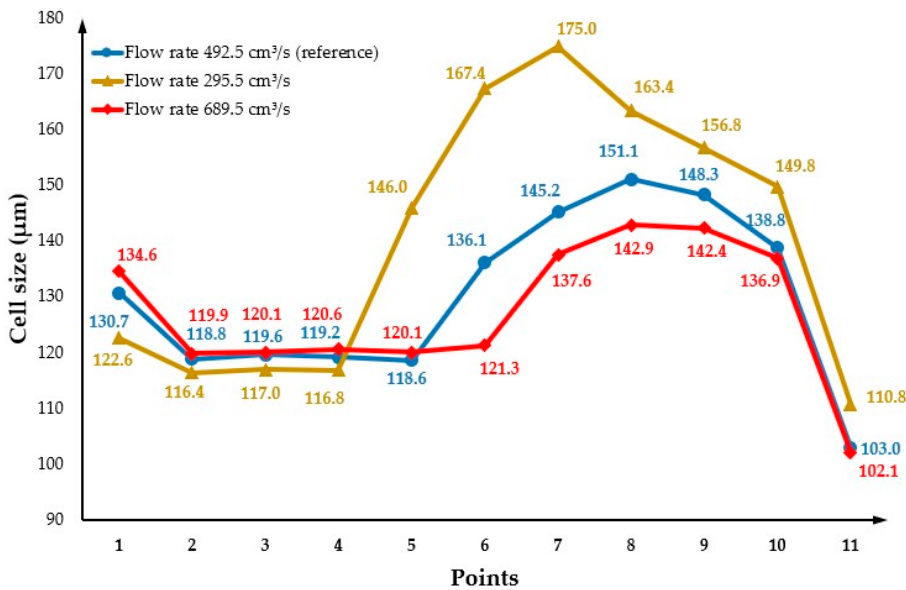
Figure 20. Cross-section variation in cell size as a function of flow rate.